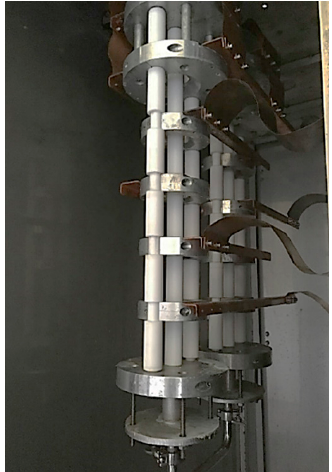
Figure 2. Possible applicator for liquid products.